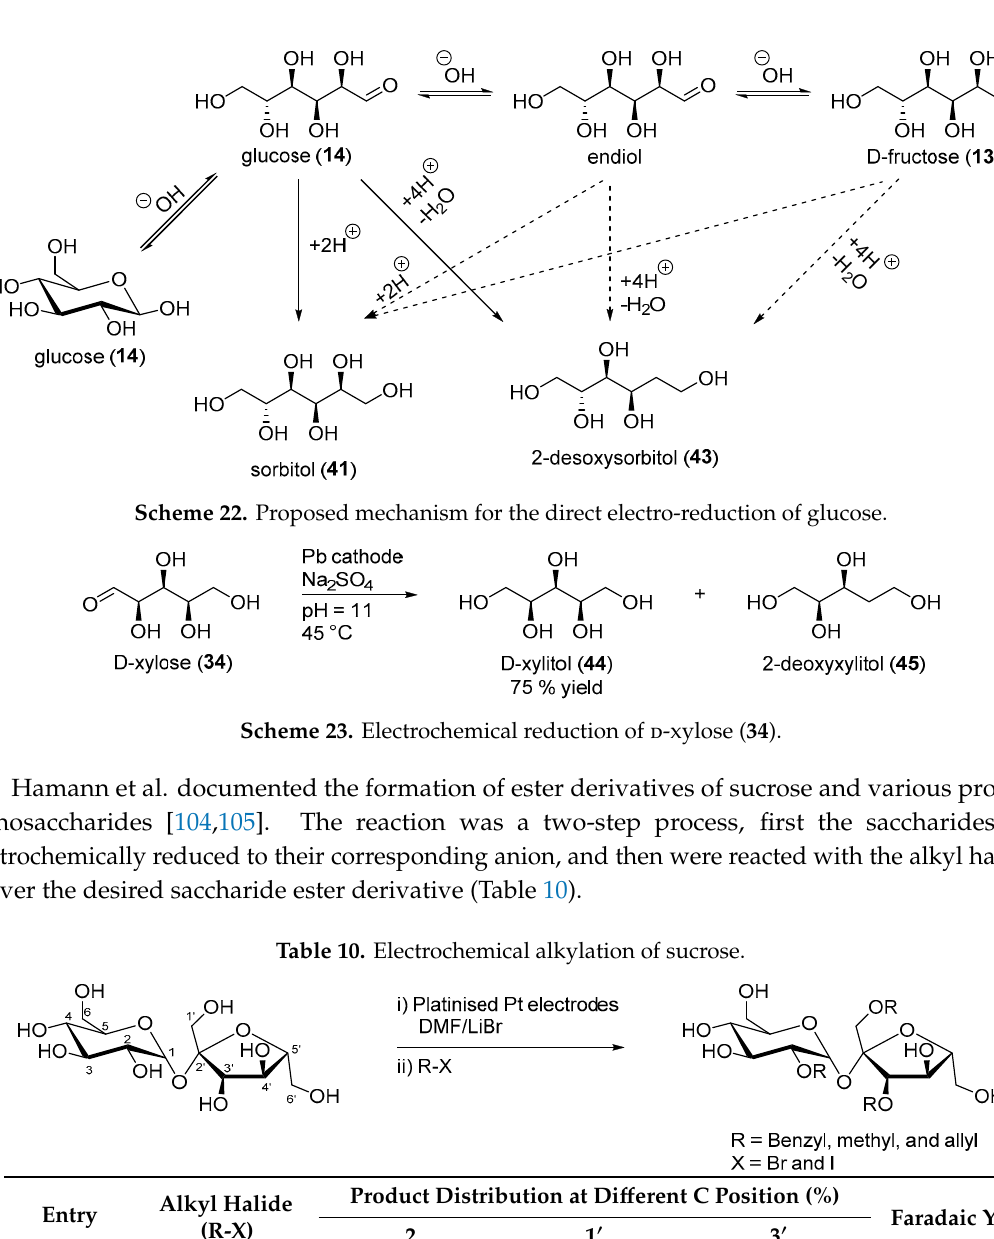
Table 10. Electrochemical alkylation of sucrose.